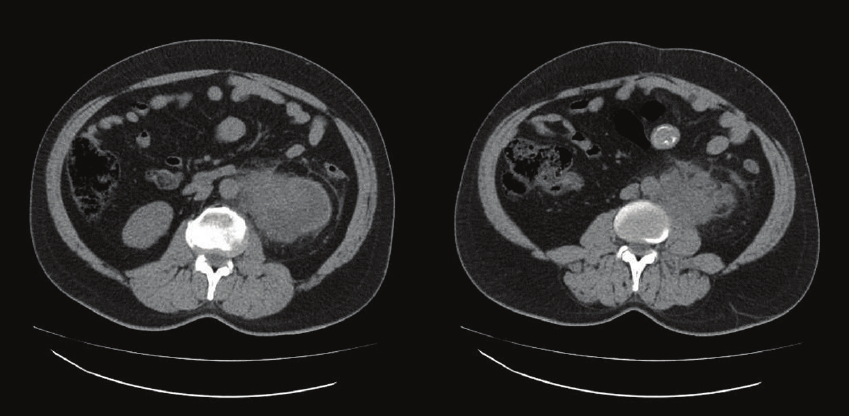
Figure 2: 8.5 × 7.5 cm lymph node surrounding the left proximal ureter and the abdominal aorta in the left para-aortic area on noncontrast computed